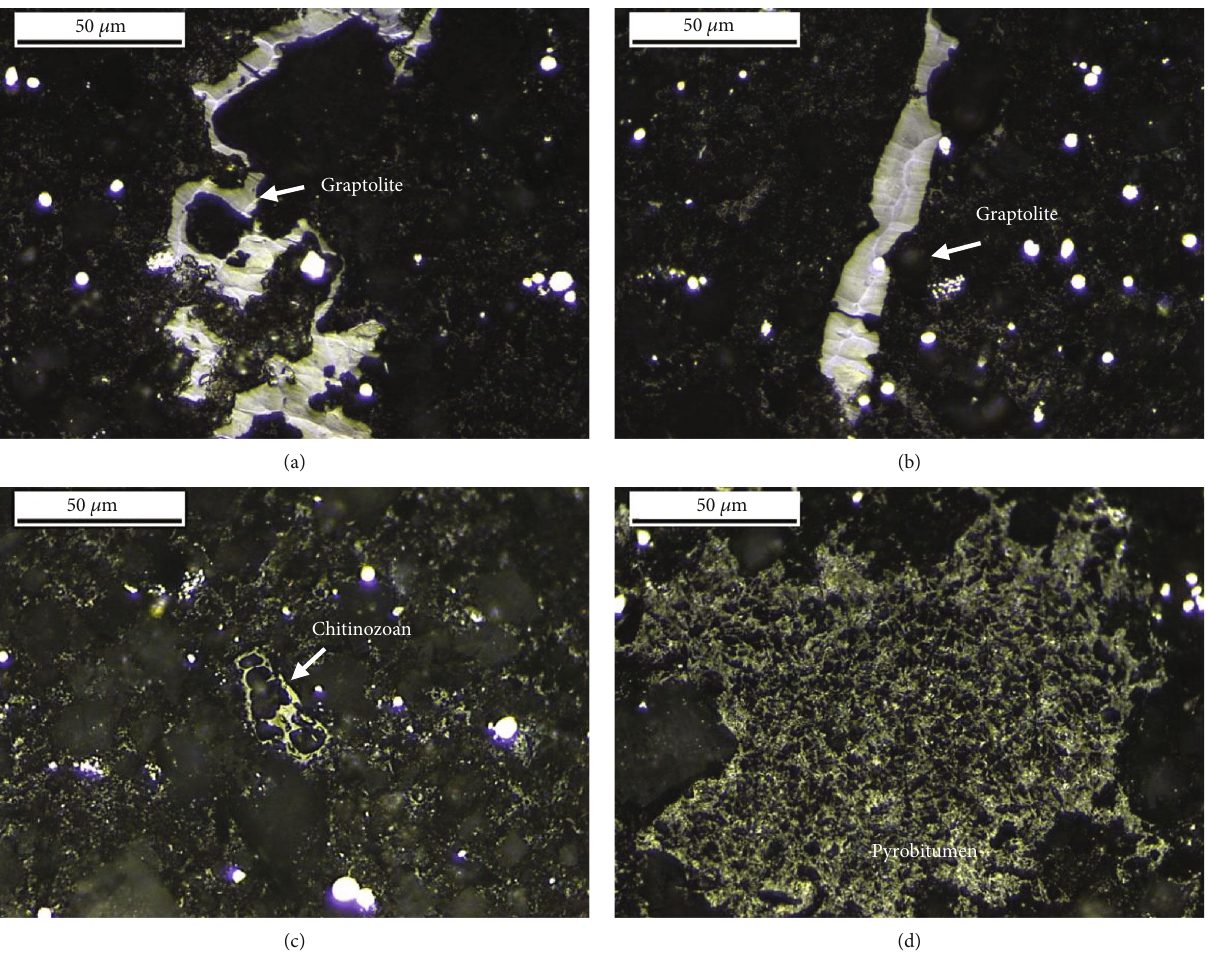
Figure 5: Organic petrography photomicrographs (oil immersion, white incident light) showing typical types and morphology of organic matter in Wufeng-Longmaxi shale samples. (a, b) Graptolite fragment with biological shape and fi brous structure within its cell wall. (c) Chitinozoan fragment with a segment or scalene shape. (d) Pyrobitumen of ~ 40 micrometers in size fi lling the shale